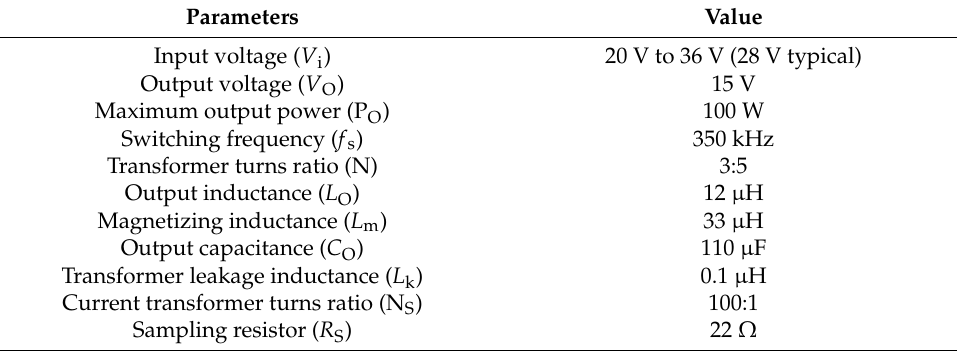
Table 2. Key parameters of the